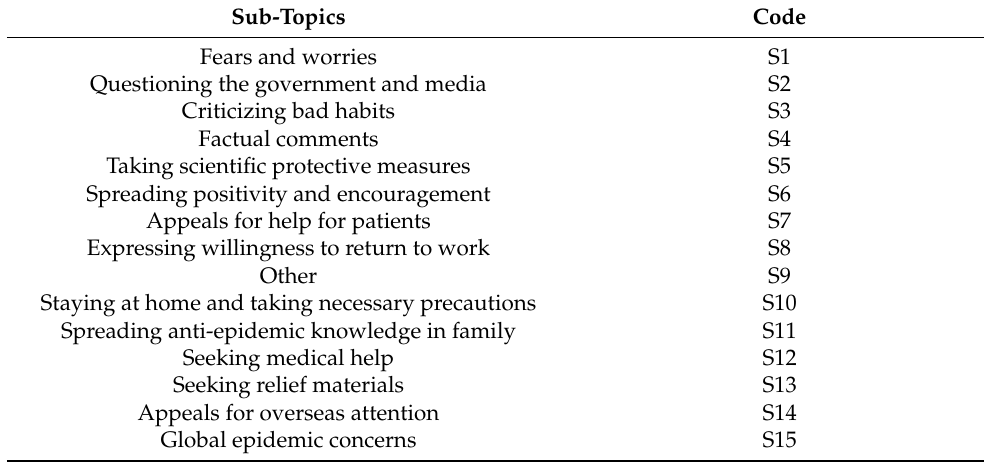
Table 1. The sub-topic names and corresponding